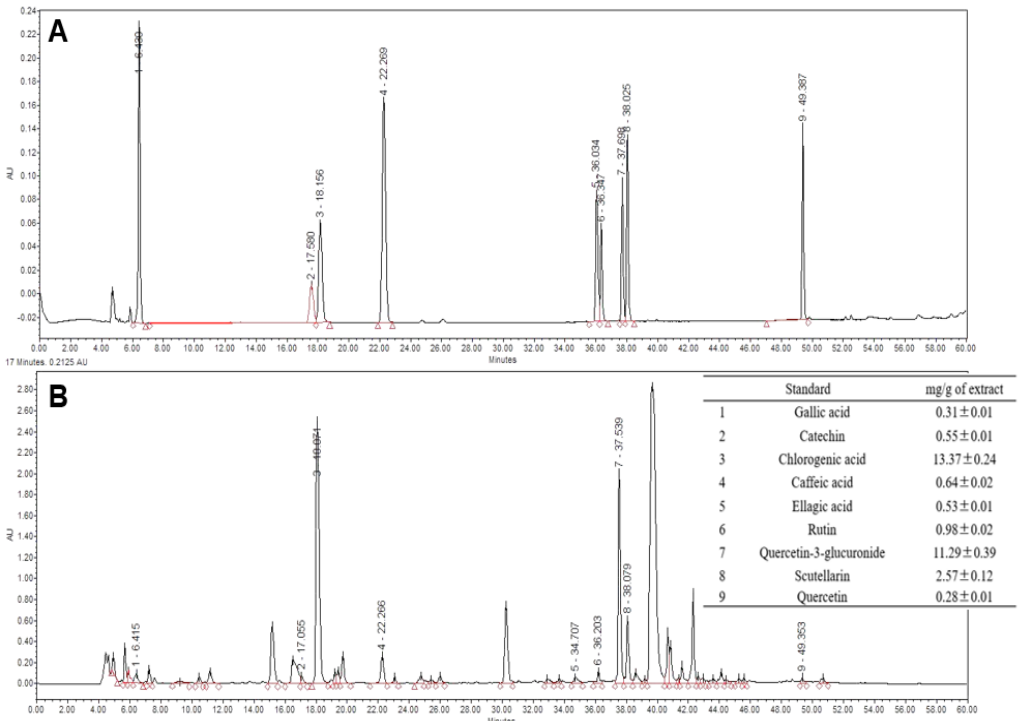
Figure 6. HPLC chromatogram of ( A ) standard references comprised of polyphenols and ( B ) green lettuce leaf extract.